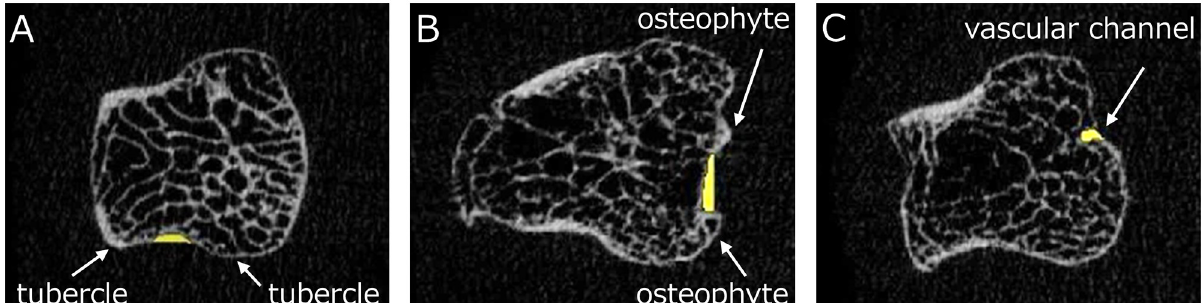
Fig 2. Typical false-positive patterns of erosions in our algorithm. A. Physiological concavity between tubercles (white arrows: tubercles). B. Pseudo- concavity formed by osteophytes (white arrows: osteophytes). C. Small cortical interruption or vascular channel (white arrow: vascular channel).